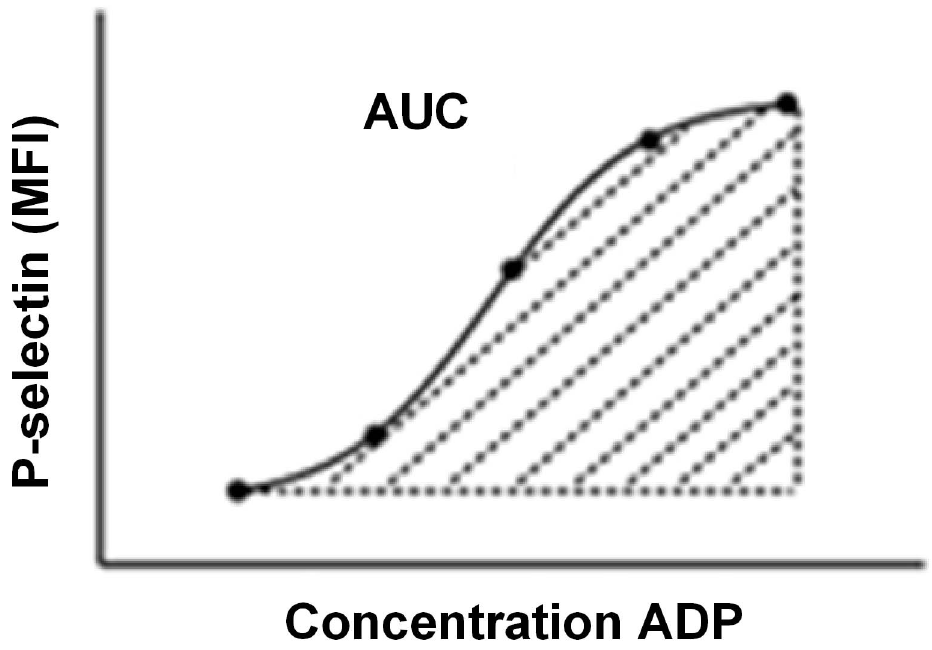
Figure 1. Conversion of dose-response curve into area under the curve. In order to compare total platelet reactivity between patients, we derived the area under the curve from each dose response curve. MFI=mean fluorescence intensity, AUC=area under curve, ADP=adenosine diphosphate.